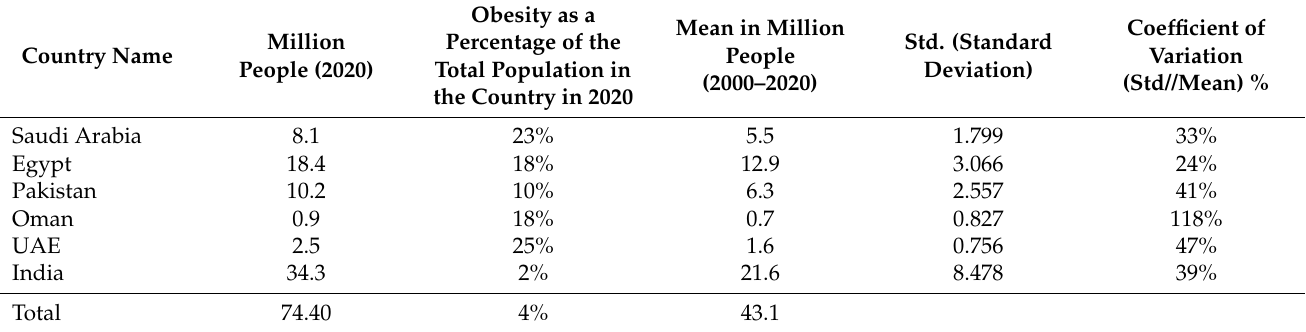
Table 6. Mean value of the number and percentages of obese people in million from 2000 to